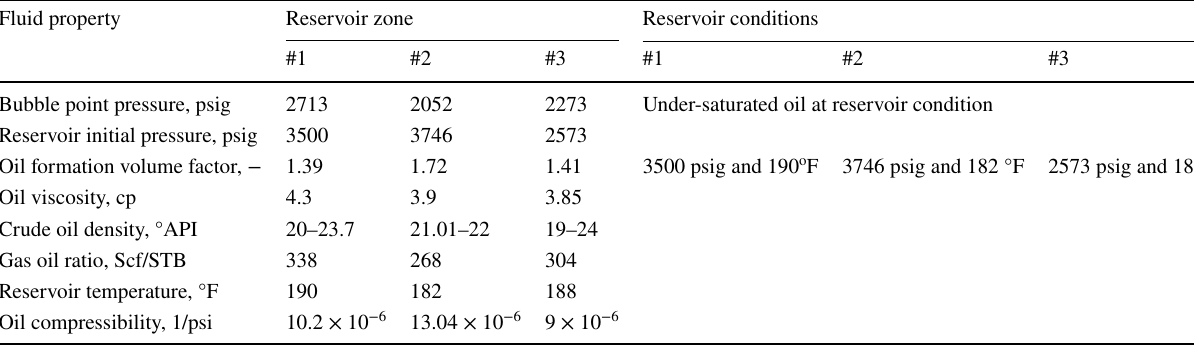
Table 4 Fluid properties of oil reservoirs in the Reshadat field Fluid